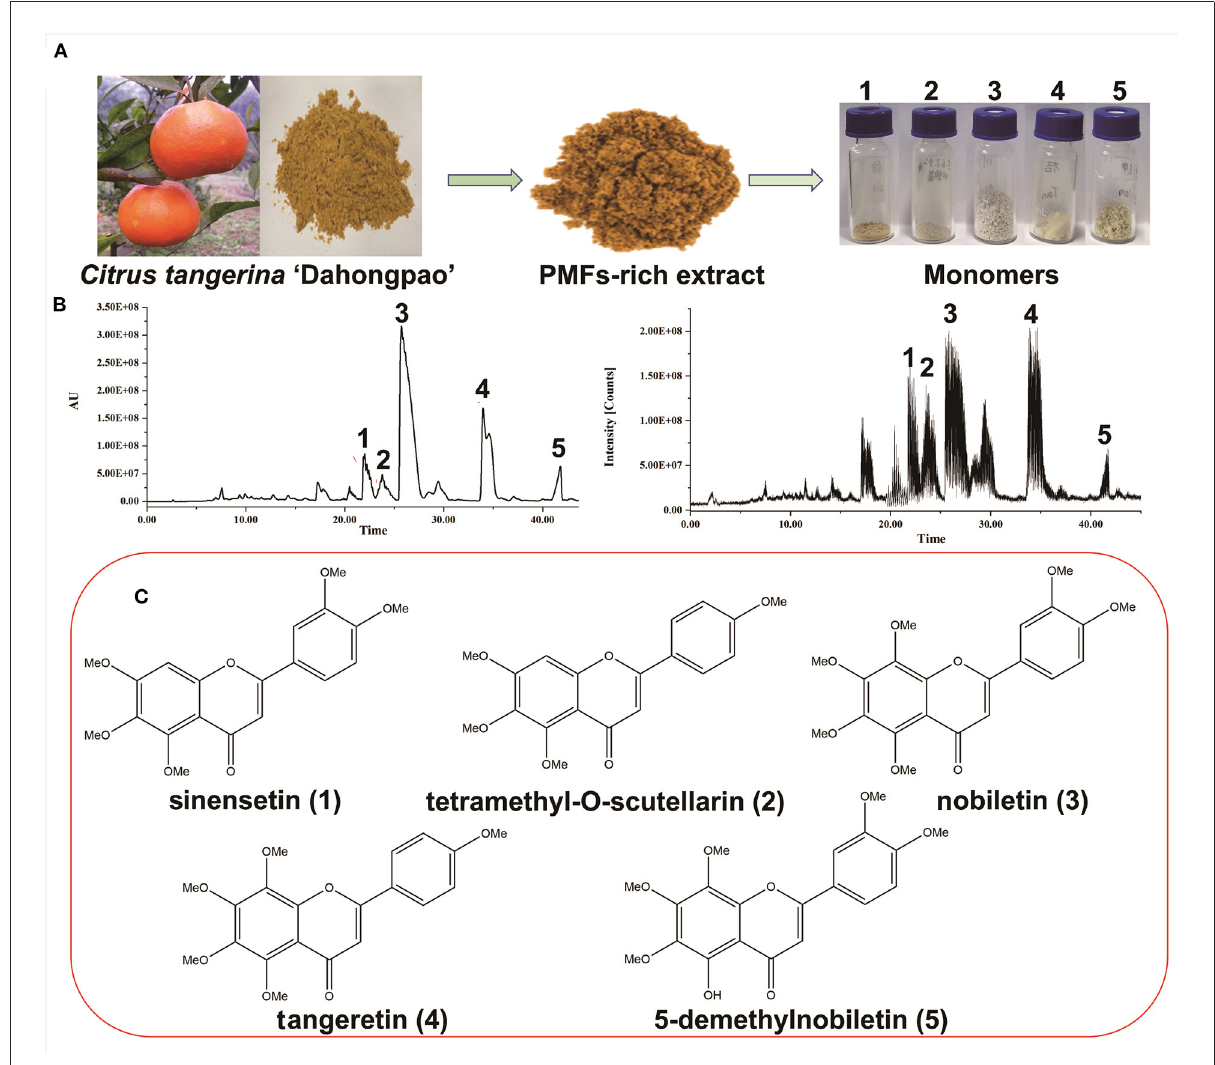
FIGURE1 Purification and identification of polymethoxyflavones (PMFs) from Citrus reticulata “Dahongpao.” (A) The preparation of PMFs; (B) Chromatogram and MS E ion profile of PMFs; (C) Chemical structure of PMFs.